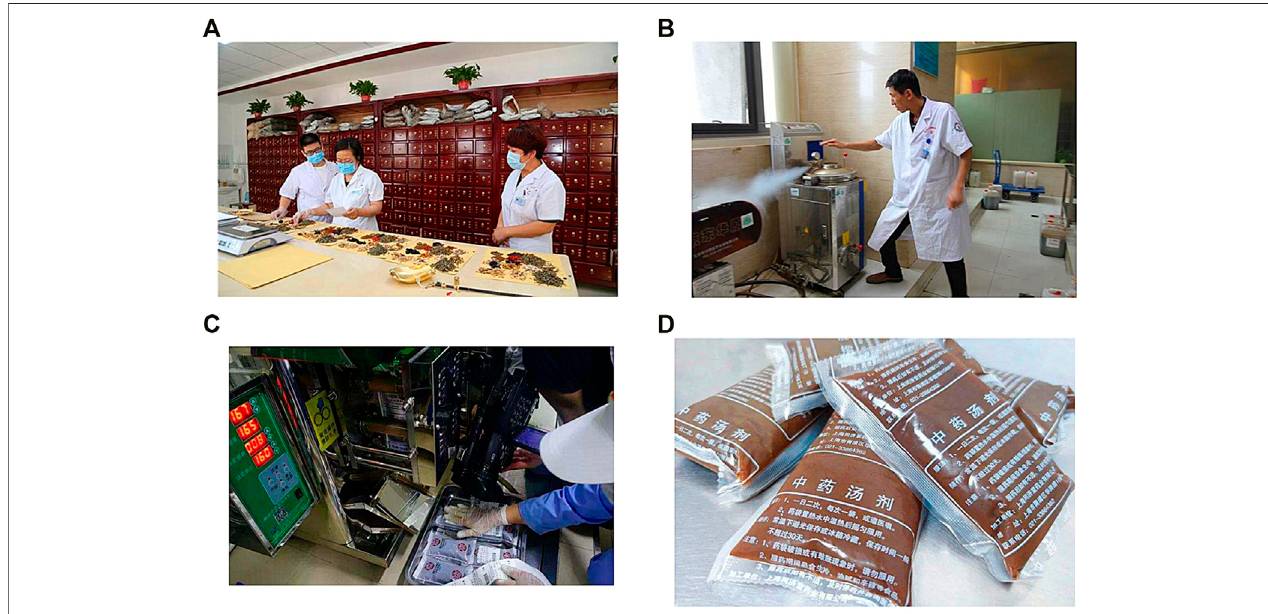
FIGURE2| Theprocedure forpreparing adecoction (A) ,herbs preparation; (B) ,machinedecocting; (C) , decoction packing; (D) ,decoction packages distributed to participants.